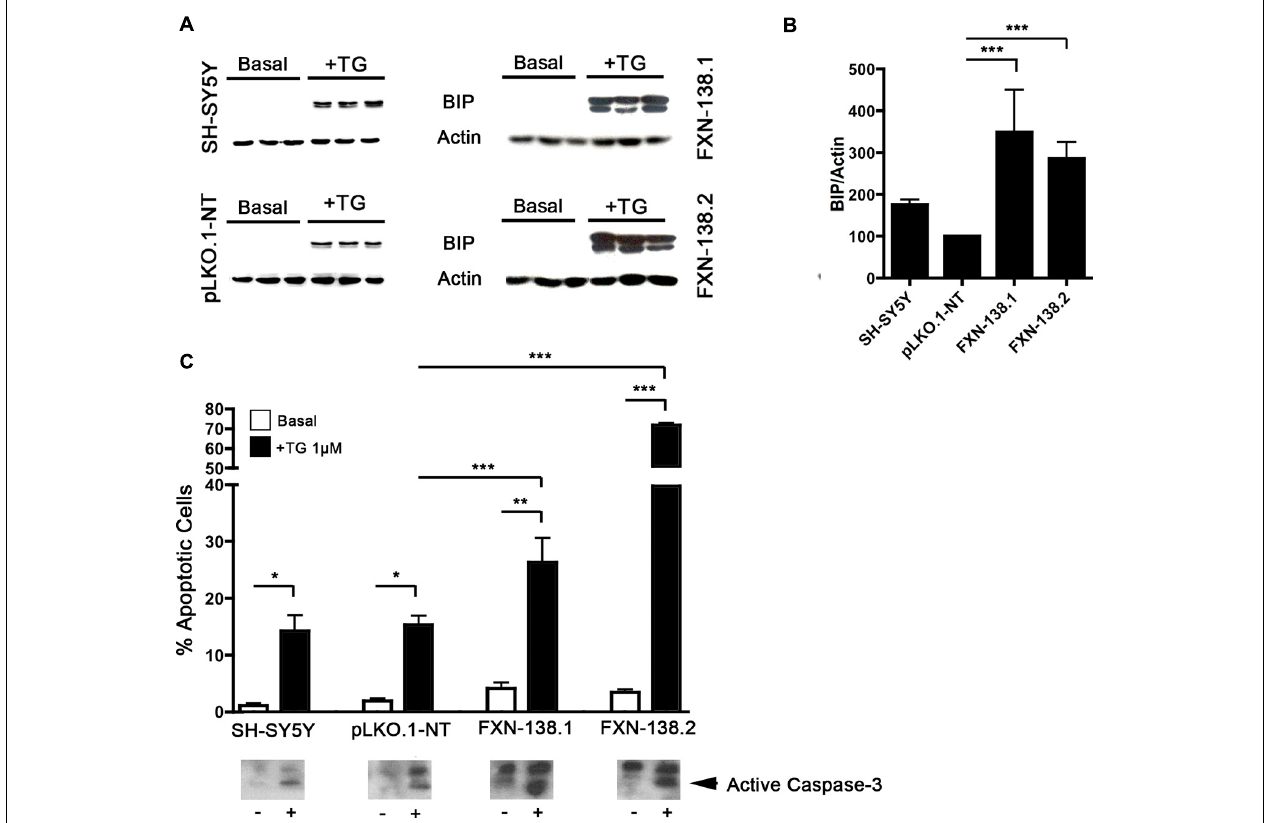
FIGURE 9 | FXN depletion results in increased endoplasmic reticulum (ER) stress. (A) Western blot analysis of ER stress marker BIP in control and FXN-deficient cells in three independent samples. (B) Normalized intensities expressed as a percentage of the BIP intensity shown in (A) . Actin was used as a loading control. The columns and bar show the mean and standard deviation. Student’s t -test, FXN-138.1 p = 0.008, FXN-138.2 p = 0.023 versus pLKO.1-NT. (C) Quantification of apoptotic cells by flow cytometry. Untreated cells (white bars) and cells treated with thapsigargin (TG, black) were fixed and stained with propidium iodine. The subG1